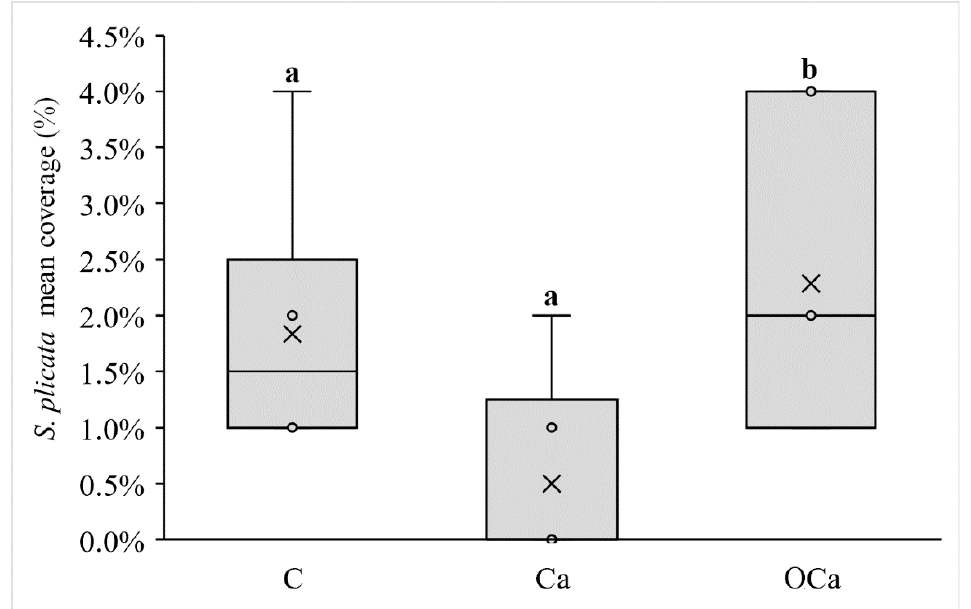
Figure 4. Boxplots of S. plicata coverage area on panels of the three experimental conditions. “ × ” in the plots indicates mean values. C: control panels, (i.e., uncaged); OCa: open-caged panels, (i.e., artifact control); Ca: caged panels. Significant differences among treatment levels ( p < 0.05) are indicated by